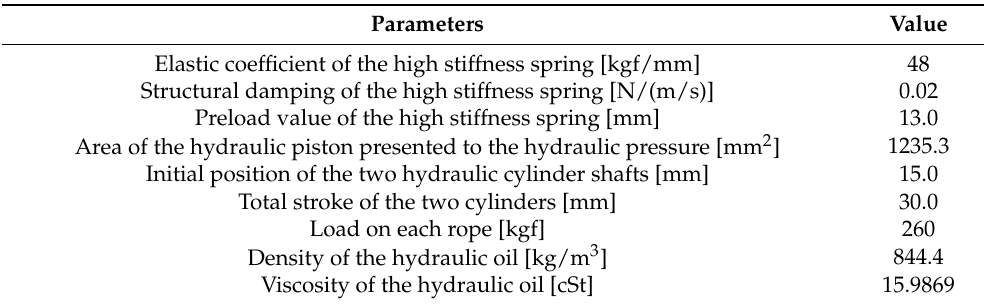
Table 1. The default simulation